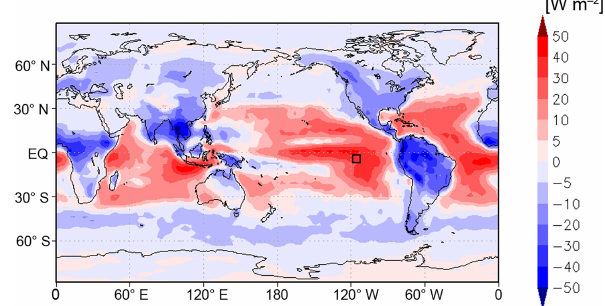
Figure 9. Changes in annual mean TOA shortwave CRE induced by implementing a shallow convection parameterization and parame- ter tuning in the MIROC5 AGCM. The black square in the eastern tropical Pacific indicates the position of a grid point focused on in Fig. 10.